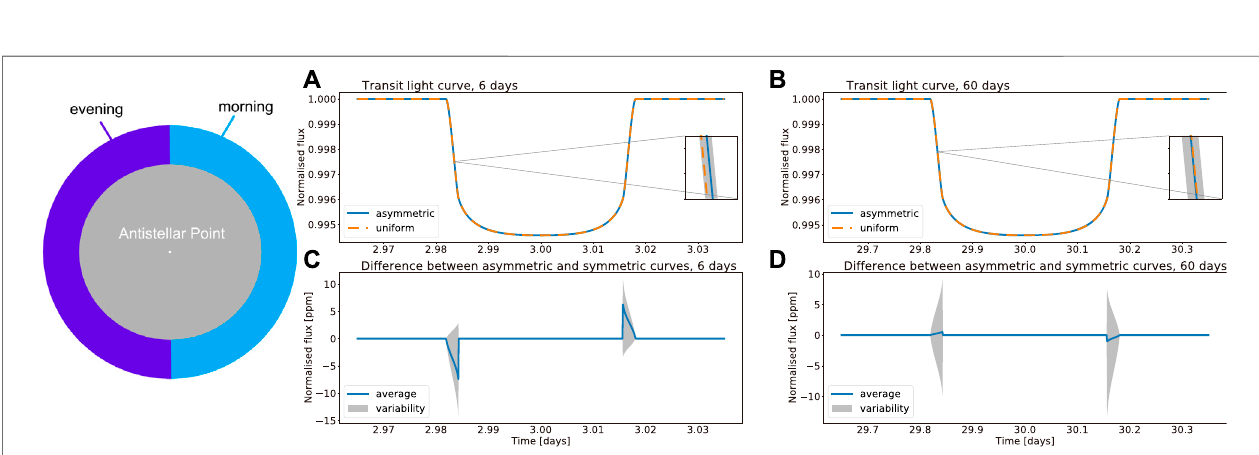
FIGURE7| ThesaturationeffectoficecloudwaterontransmissionthicknessintherapidlyrotatingcaseofsixEarthdays.Theshadingsin (A) showtherangeofice cloud water content along the morning terminator. We arti fi cially set the maximum value of ice cloud water to 0, 1, and 7 mg kg − 1 in (A) , and their corresponding transit atmospheric thicknesses are shown in (B) . When the maximum value of ice cloud water is set to 7 mg kg − 1 , the transit atmospheric thickness is almost the same as the original, and we call this phenomenon “ the saturation effect ” .